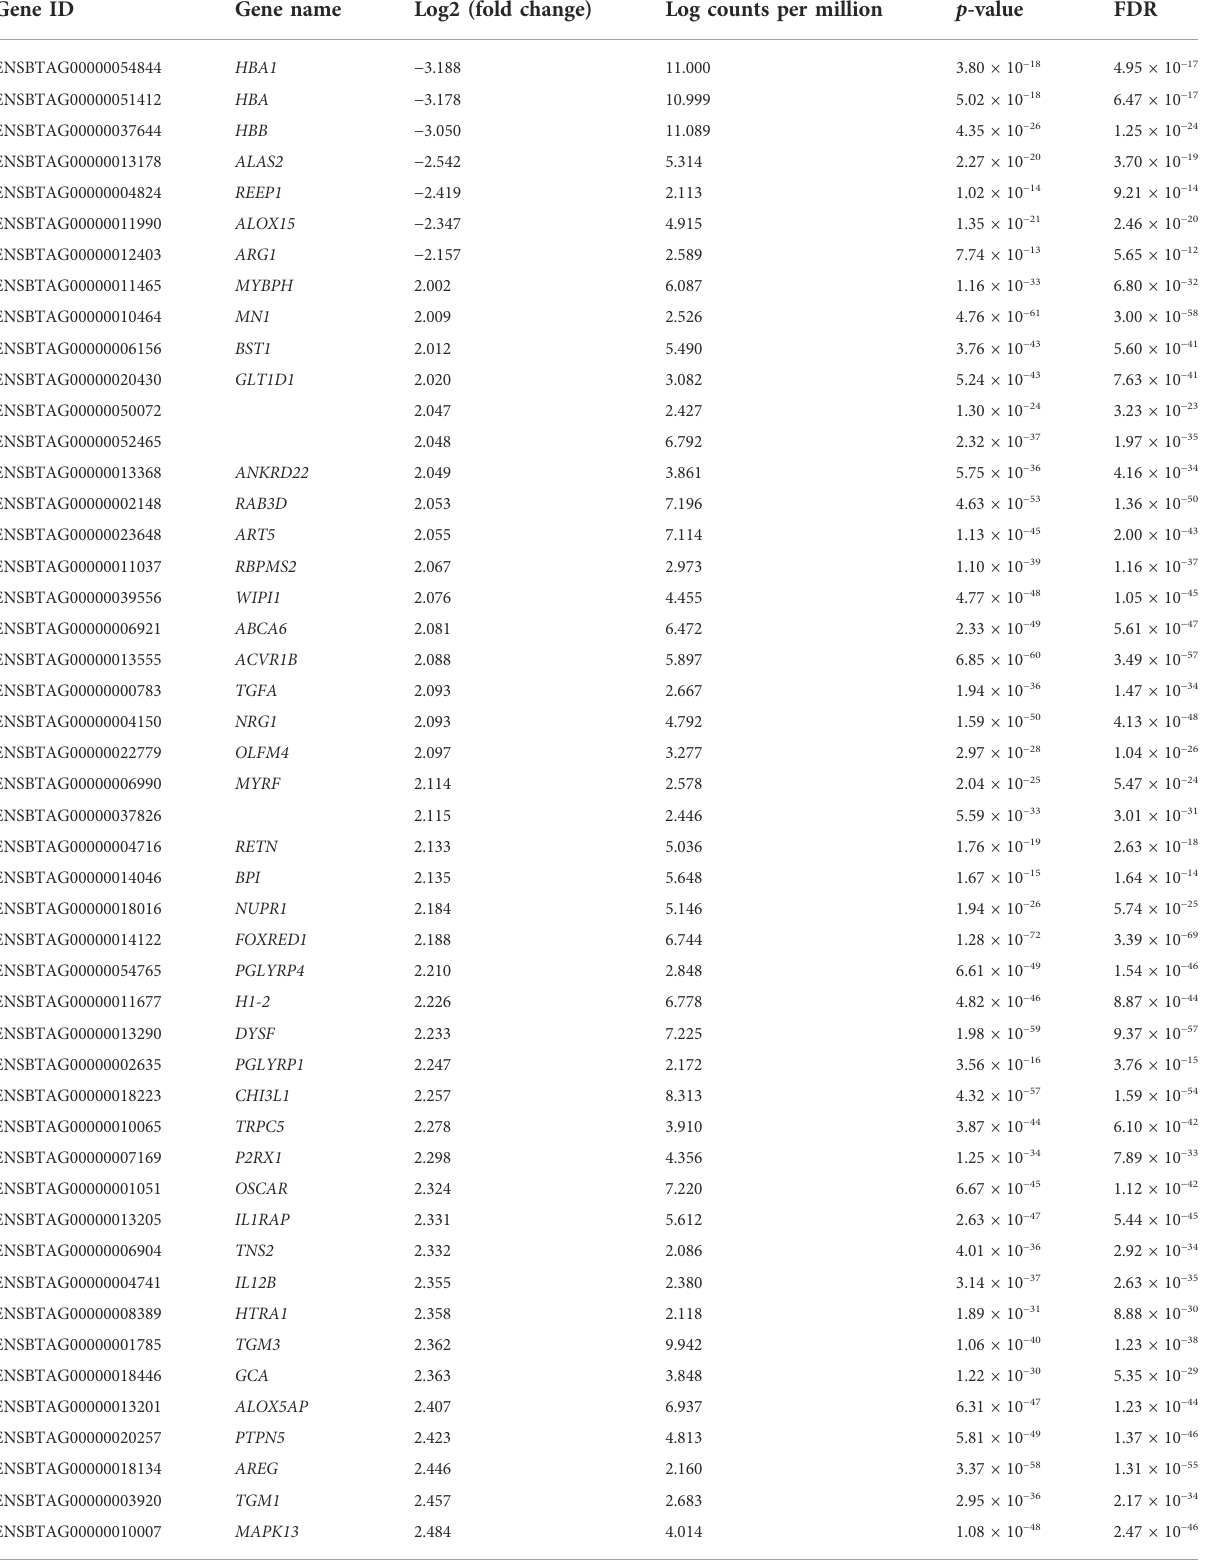
TABLE 2 Differentially expressed genes between BRD and non-BRD